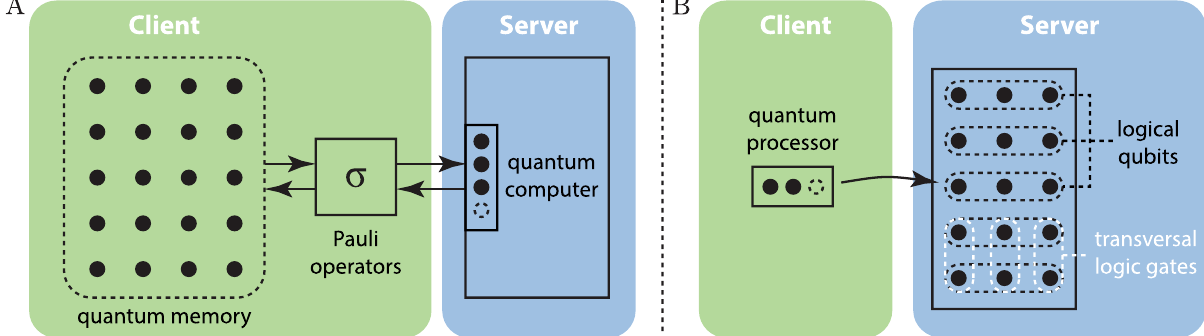
Fig. 3 a An illustration of the BQC setting considered by Childs. 27 In this scenario, the client has a large quantum memory together with the ability to perform Pauli operations on qubits and to transmit them to the server. However they lack the ability to perform other gates, such as Toffoli or Hadamard gates. b An illustration of the setting considered by Aharonov, Ben-Or and Eban, 12 in which the client has access to a quantum computer capable of performing arbitrary operations on a constant number of